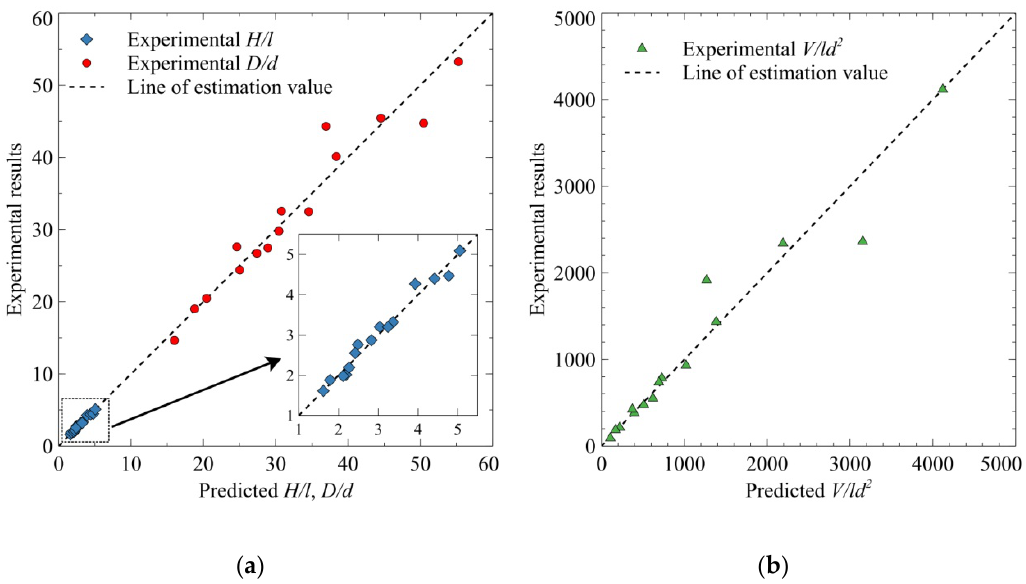
Figure 12. The experimental results versus the predicted values of the impact crater parameters: ( a ) experimental H / l and D / d versus predicted values; ( b ) experimental V / ld 2 versus predicted values.